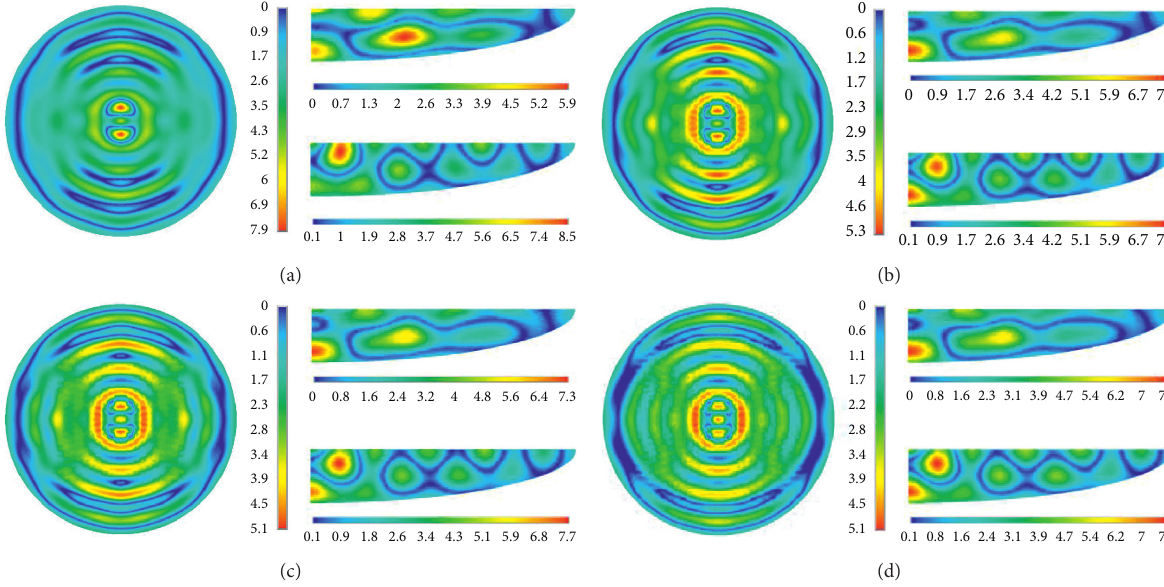
Figure 8: The displacement amplitude of the homogeneous sedimentary basin ( f � 2.0 Hz): (a) no buildings; (b) buildings 14 × 14; (c) buildings 20 × 20; (d) buildings 26 × 26.